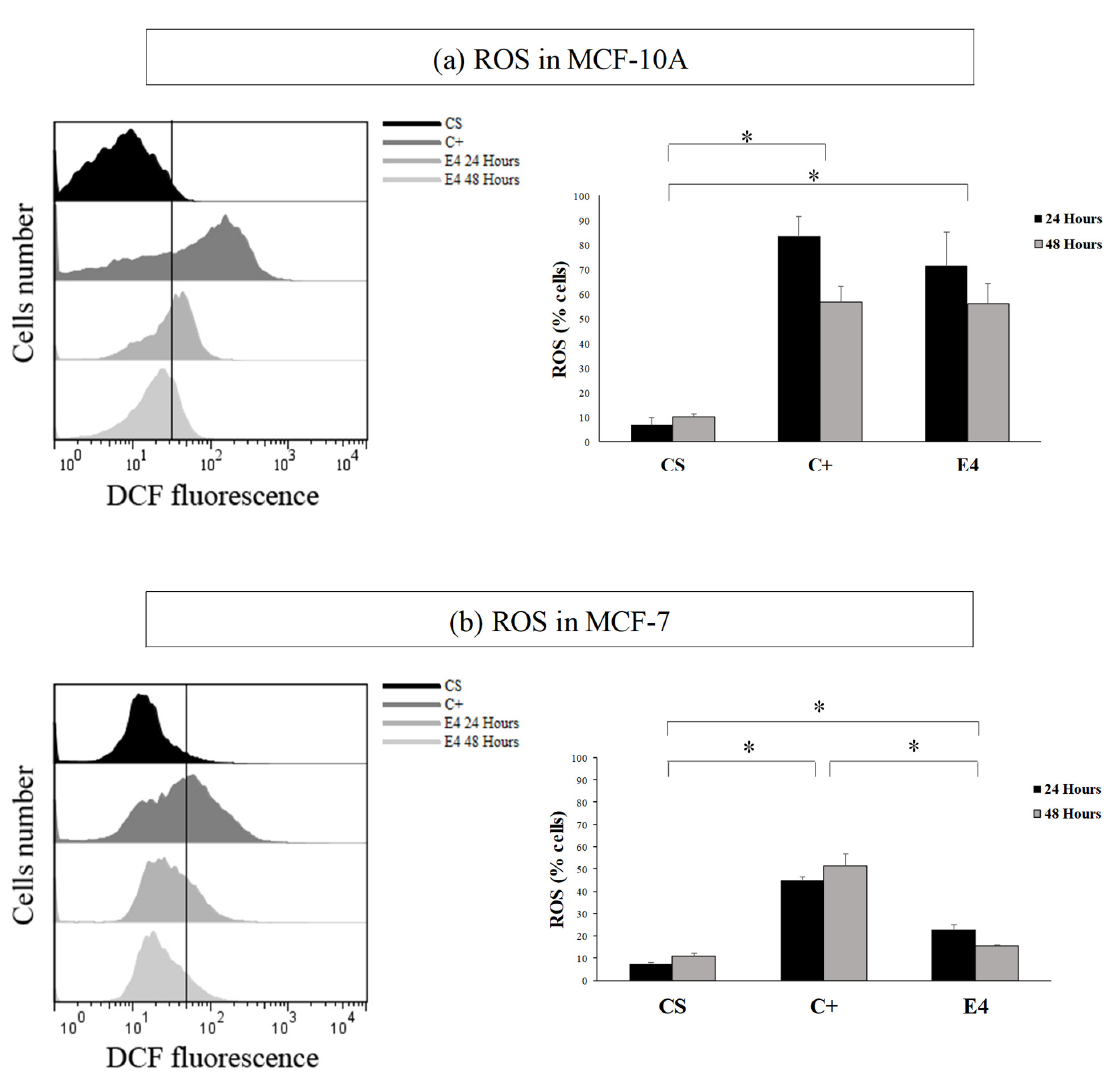
Figure 3. Comparative histogram between cell number and DCFH 2 -DA fluorescence, on lines ( a ) MCF-10A and ( b ) in MCF-7. CS = solvent control; C+ = positive control; E4 = post-distillation hydro-ethanolic leaf extract obtained by ultrasound-assisted SE. Data are expressed as mean percentages ± standard deviation ( n = 3). * Corresponds to significant differences between treatments per cell line, ( p < 0.05).